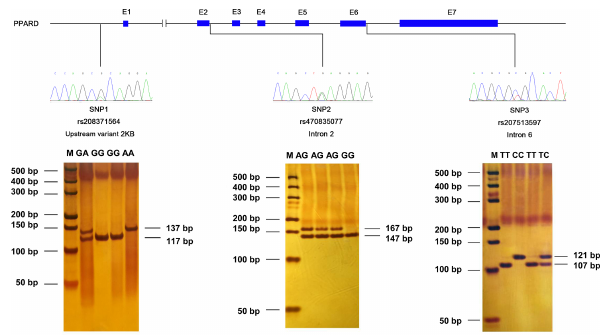
Figure 2. Schematic characteristic of SNPs identified in bovine PPARD and genotyping. From top to bottom: structure of bovine PPARD , mutant peaks of sequencing, details of SNPs identified, and electrophoretogram of